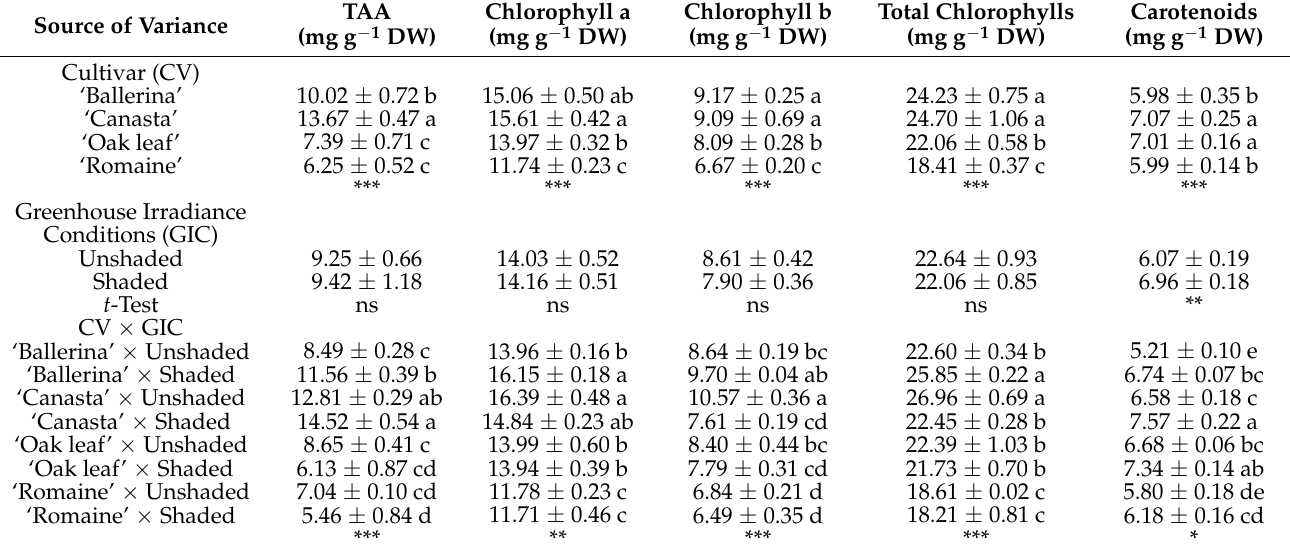
Data are mean values ± standard error, n = 3. Mean comparisons were performed by Duncan’s Multiple Range Test (DMRT) for CV and by t -Test for GIC. Different letters within columns indicate significant mean differences compared by DMRT ( p = 0.05). ns, *, **, and *** denote nonsignificant or significant effects at p ≤ 0.05, 0.01, and 0.001,